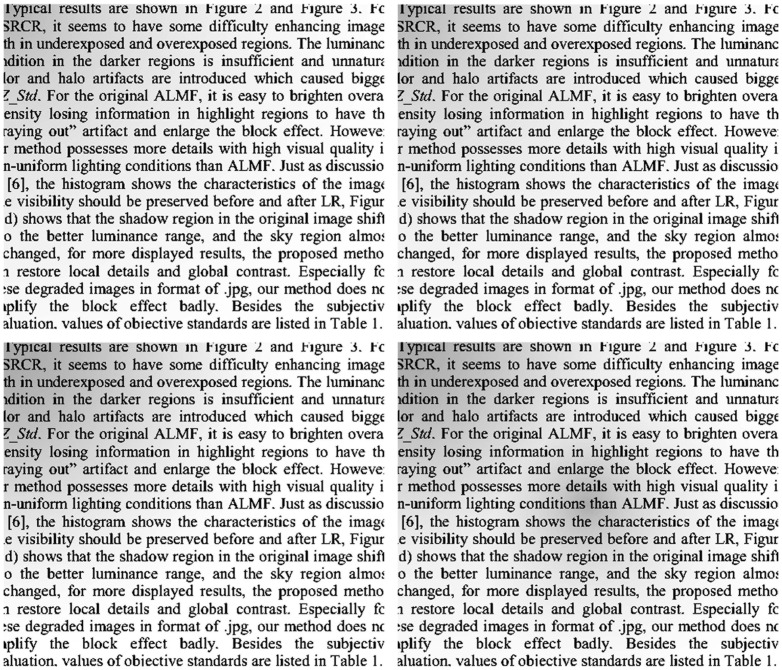
Results of method proposed by[16].